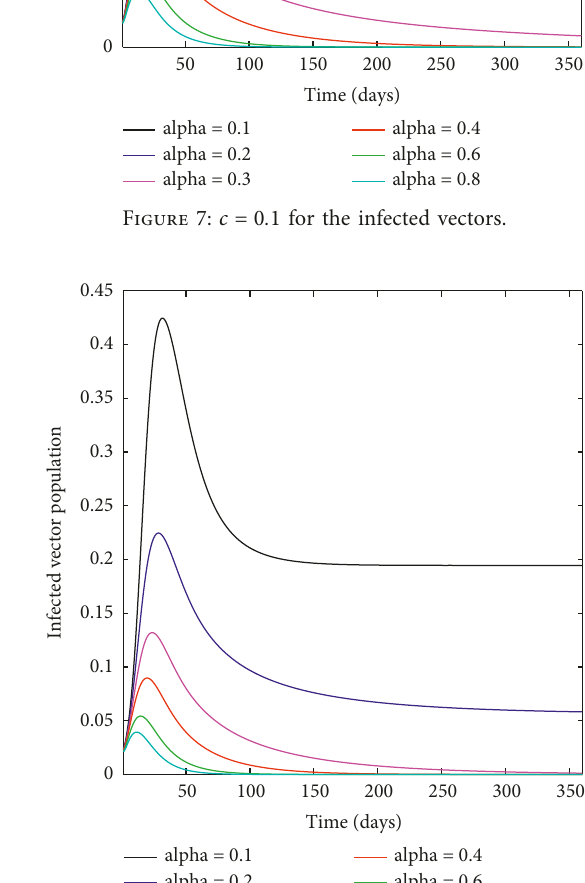
Figure 6: c � 0 for the infected vectors.